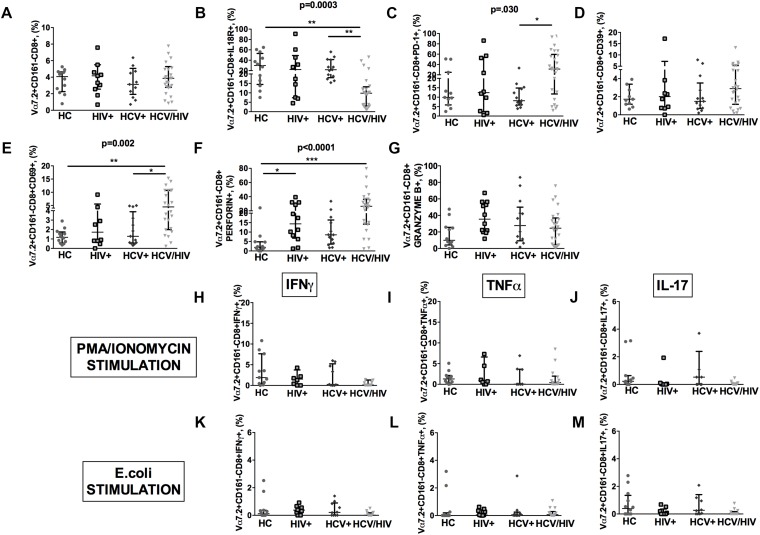
Frequency, phenotypes and cytokine production of Vα7.2+CD161-CD8+ T-cells. The lines indicate the significant comparison between two groups. ∗ indicates the p-value for each pair of groups: ∗
p < 0.05, ∗∗
p < 0.01, ∗∗∗
p < 0.001. (A) The frequency of circulating Vα7.2+CD161-CD8+ subset was similar among the four study groups (HC: 4.07%, HIV+: 4.17%, HCV+: 3.13%, HCV+/HIV+: 3.87%, p = 0.918). (B) HCV+/HIV+ co-infected patients featured significantly lower levels of IL18R (HC: 29.8%, HIV+: 22%, HCV+: 21.7%, HCV+/HIV+: 9.81%, p = 0.0003). (C) Similar levels of CD39 on Vα7.2+CD161-CD8+ were found (HC: 1.73%, HIV+: 2.01%, HCV+: 1.49%, HCV+/HIV+: 2.89%, p = 0.667). (D) Vα7.2+CD161-CD8+PD-1+ T-cells were significantly increased in co-infected subjects (HC: 9.89%, HIV+: 12.4%, HCV+: 8.15%, HCV+/HIV+: 31.2%, p = 0.030). (E) The highest levels of Vα7.2+CD161-CD8+CD69+ were found in HCV/HIV patients (HC: 1.17%, HIV+: 1.72%, HCV+: 1.28%, HCV+/HIV+: 4.46%, p = 0.002). (F) We observed significantly higher levels of perforin (HC: 1.91%, HIV+: 14.3%, HCV+: 8.54%, HCV+/HIV+: 26.5%, p < 0.0001) in virally infected patients. (G) Similar granzyme B levels were found in virally infected patients, as compared to the control group (HC: 10%, HIV+: 35.4%, HCV+: 27.7%, HCV+/HIV+: 24.6%, p = 0.105). Vα7.2+CD161-CD8+ T-cell population produced very limited cytokine amount following both (H–J) PMA/ionomycin and (K–M)
E. coli stimulation, with no differences between the study groups.